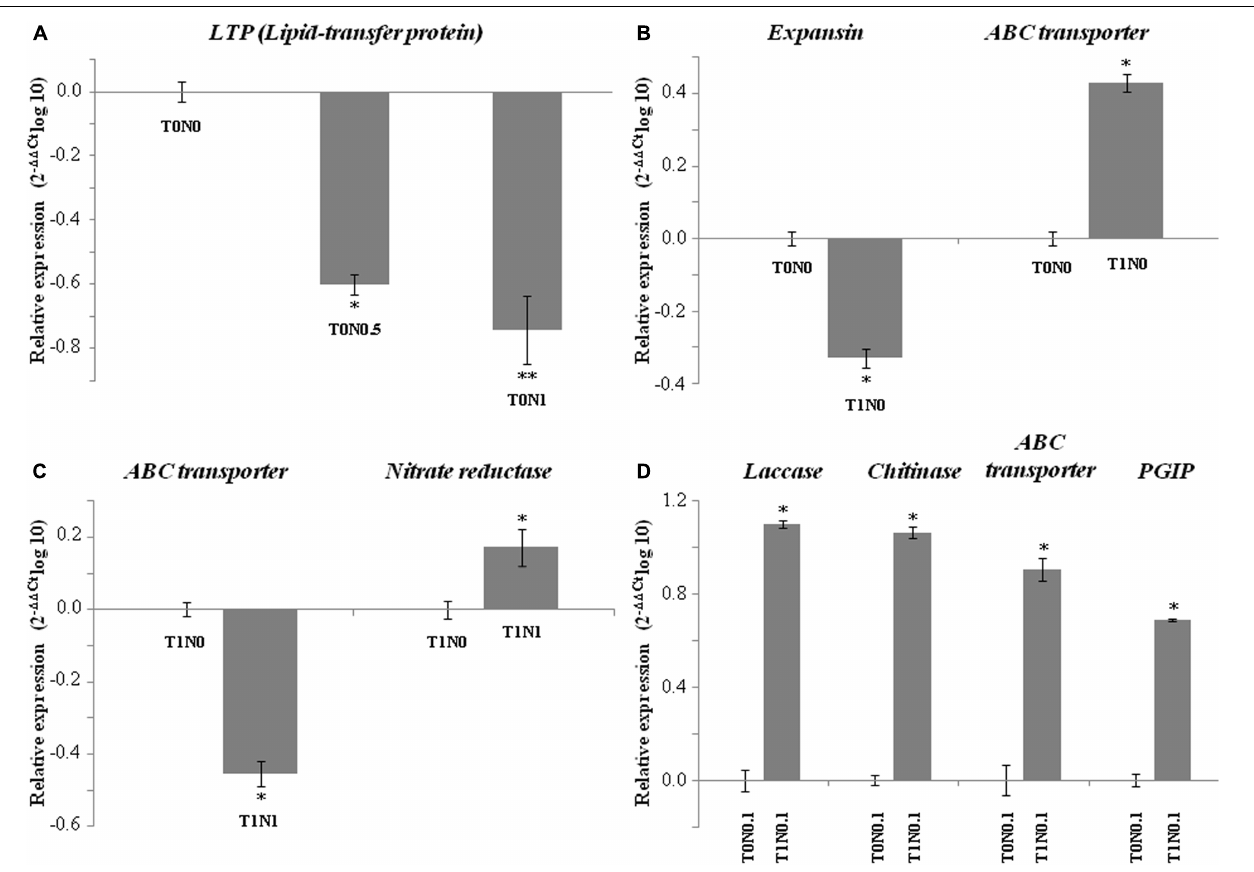
FIGURE 2 | qPCR expression analysis of seven International Wheat Genome Sequencing Consortium (IWGSC, v0.4)-referred genes of a set of 226 genes differently expressed in wheat seedling roots resulting from the GeneChip Wheat Genome Array analysis under eight different growth conditions with (T1) or without (T0) Trichoderma harzianum T34 and 0 (N0), 0.1 (N0.1), 0.5 (N0.5) or 1 (N1) mM calcium nitrate. Analyzed gene code for: (A) Lipid-transfer protein (LTP, ID TraesCS1A01G175200.1) (T0N0.5 and T0N1 compared to T0N0 conditions), (B) expansin (ID TraesCS4A01G034300.1) and ABC transporter (ID TraesCS5A01G016200.1) (T1N0 compared to T0N0), (C) ABC transporter and nitrate reductase (ID TraesCS6B01G024900.1) (T1N1 compared to T1N0), and (D) laccase (ID TraesCS3B01G489800.1), chitinase (ID TraesCS7A01G371600.1), ABC transporter, and polygalacturonase inhibitor (PGIP, ID TraesCS7B01G103900.1) (T1N0.1 compared to T0N0.1). Data are the mean of three technical replicates from two biological replicates and are displayed as the log10 of the relative quantity (RQ, 2 - DDCt ) of target genes compared with the quantity of actin gene used as a reference. For each biological replicate, roots from ten plants were